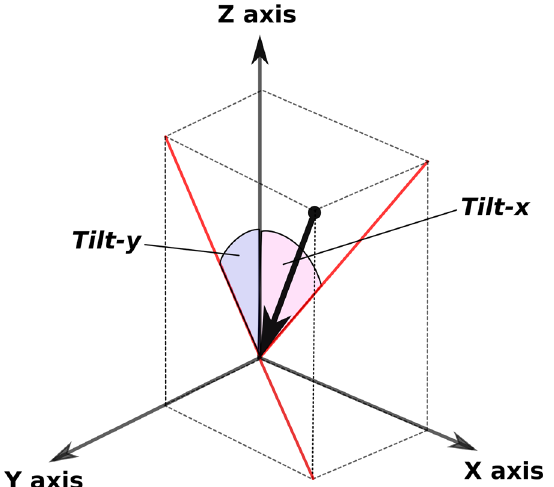
Fig. 5 The two angles (tilt-x and tilt-y) recorded for the pen. The black arrow represents the pen, and the red segments represent its projections onto the XZ and YZ planes, respectively. The fi gure comes from 21